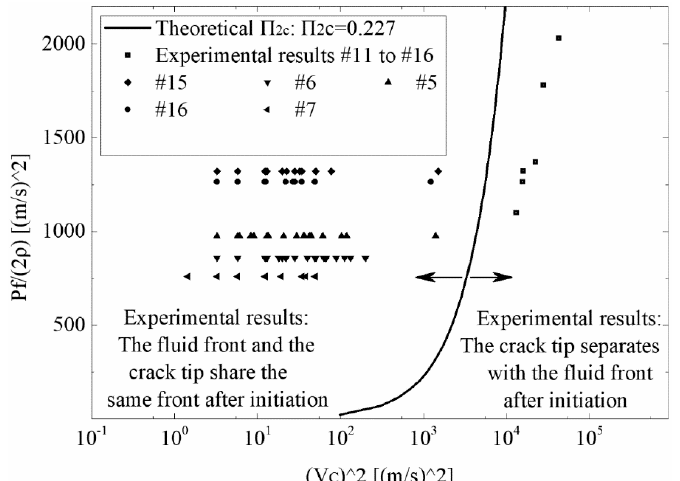
Figure 12. Verification of Π 2 c and Π 2 s compared with experimental results. The massive data on the left are extracted from varies experiments in which cracks propagate in a stepwise manner and never separate with fluid fronts. Two of the data points close to the curve of Π 2 s are shown in Figure 7a,b. The sporadic data on the right are the initiation parts of the cracks in the experiments, which are prone to the separation due to the high speed of crack tip. Both Π 2 c and Π 2 s provide good predictions of the experimental results.